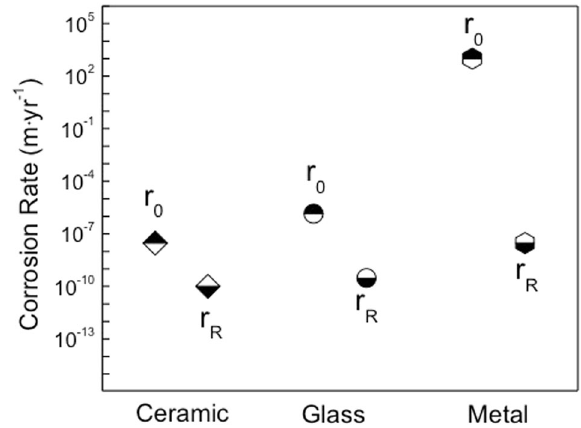
Fig. 7 Summary of estimates of initial rates of corrosion, r 0 , and residual or steady state rates, r R , for ceramics, glasses and corrosion- resistant metal alloys. The very high initial rate shown for metal passivation is a consequence of the very short timescale ( μ s) over which such rates can be measured for